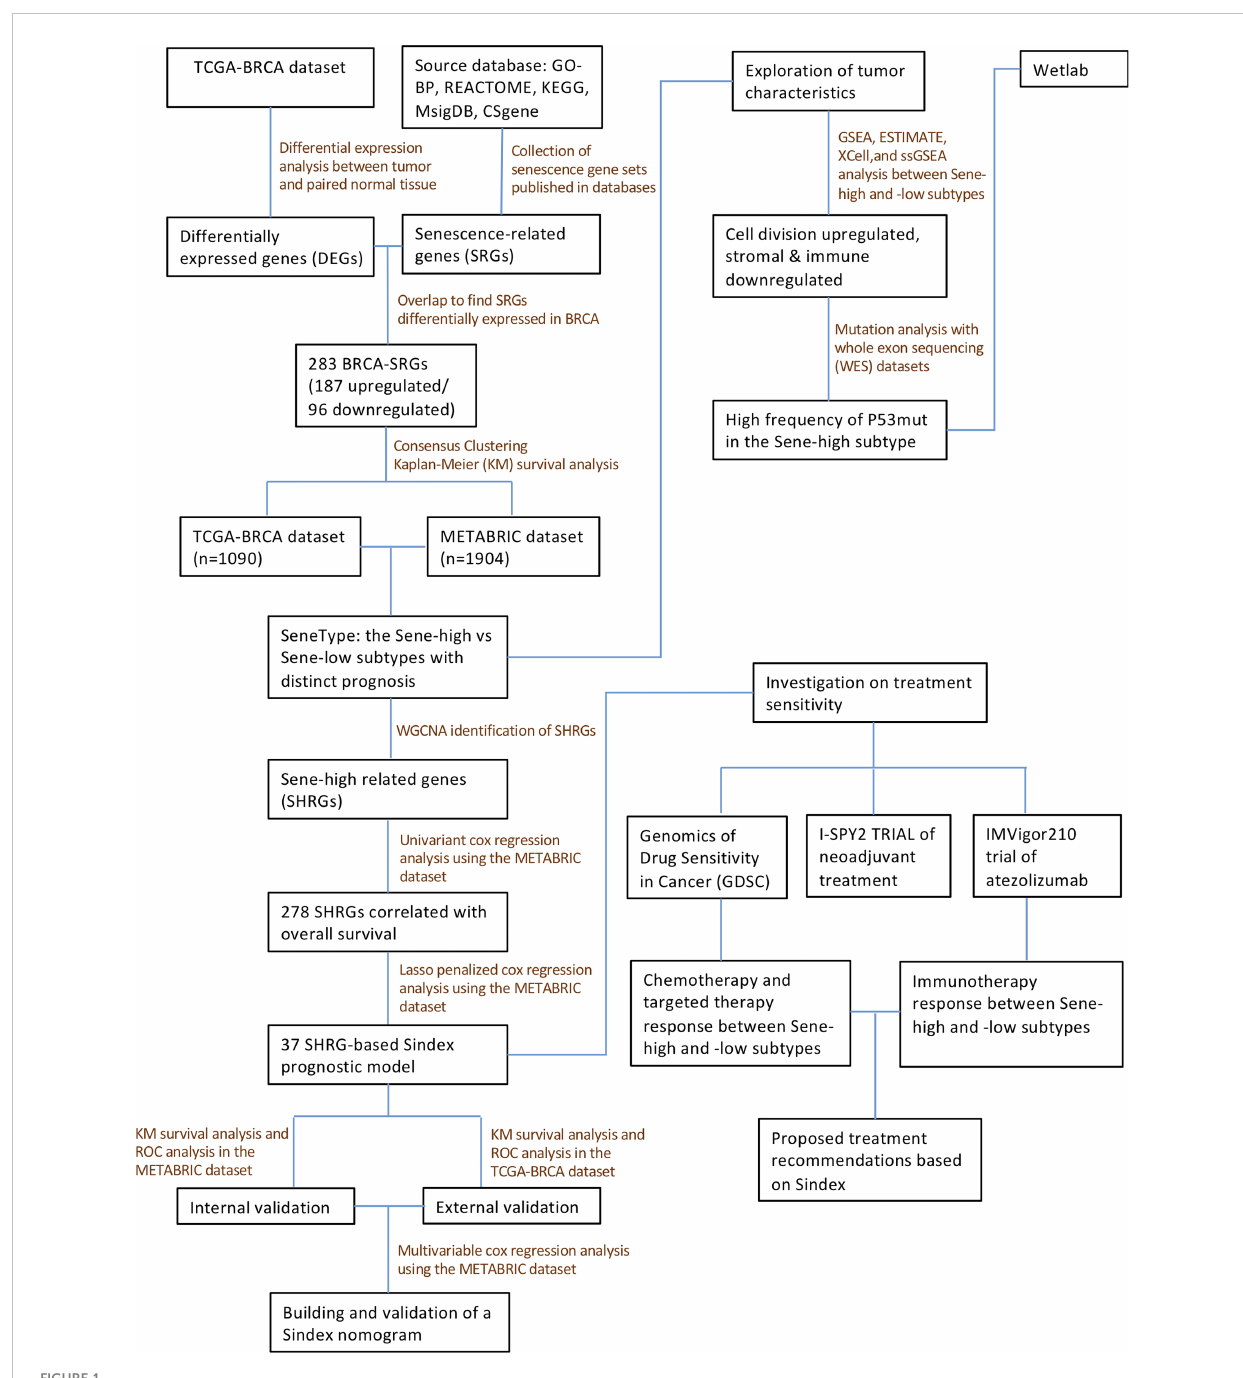
FIGURE 1 The fl ow chart describing the number of cases and work fl ow included in the study